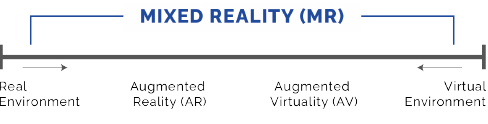
Figure 1. Milgram et al.’s (1994) seminal reality-virtuality continuum. Figure redrawn from Milgram